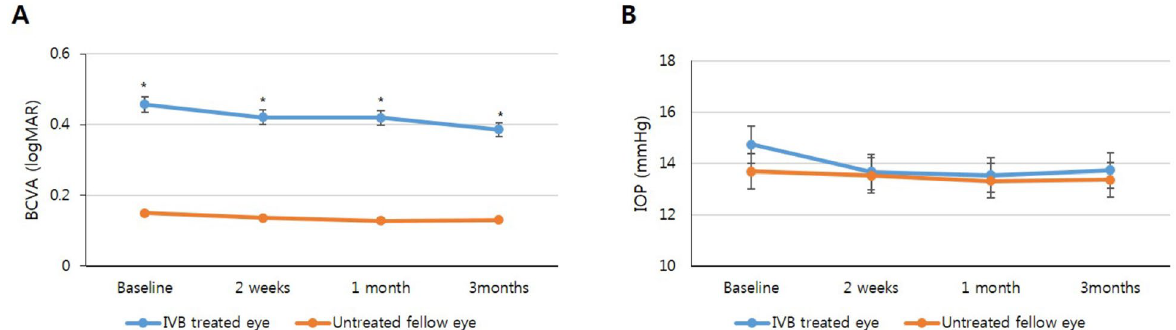
Figure 1. Changes in the best corrected visual acuity (BCVA) and intraocular pressure (IOP). ( A ) BCVA in the intravitreal brolucizumab (IVB) treated and untreated fellow eye groups. ( B ) IOP in the IVB treated and untreated fellow eye groups. The differences between the treated and control eyes are analyzed using the Mann– Whitney U -test, and significant p values are represented with